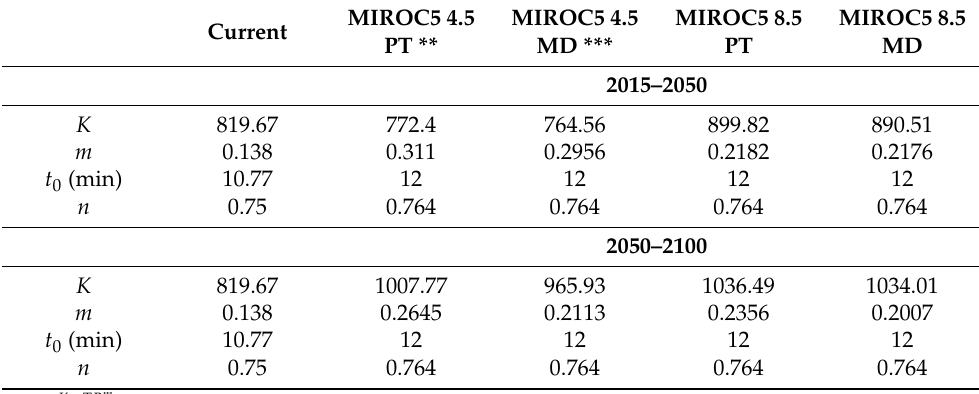
Table A1. Parameters of the IDF curves type Sherman *, for the current period and updated with climate change patterns (Macedo, 2020).